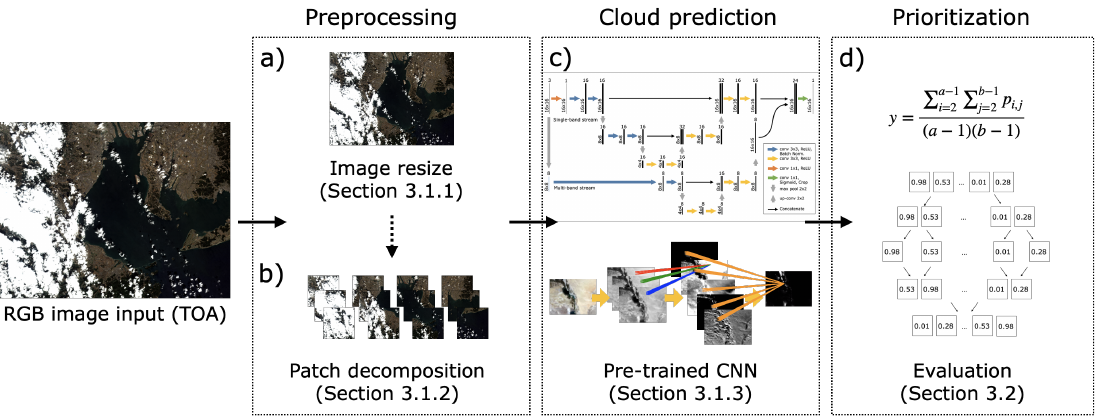
Figure 2. Overview of the flowchart of the proposed method. Each part in ( a ) image resize, ( b ) patch decomposition, ( c ) cloud coverage prediction, and ( d ) cloud coverage fraction evaluation are designed to reduce inference